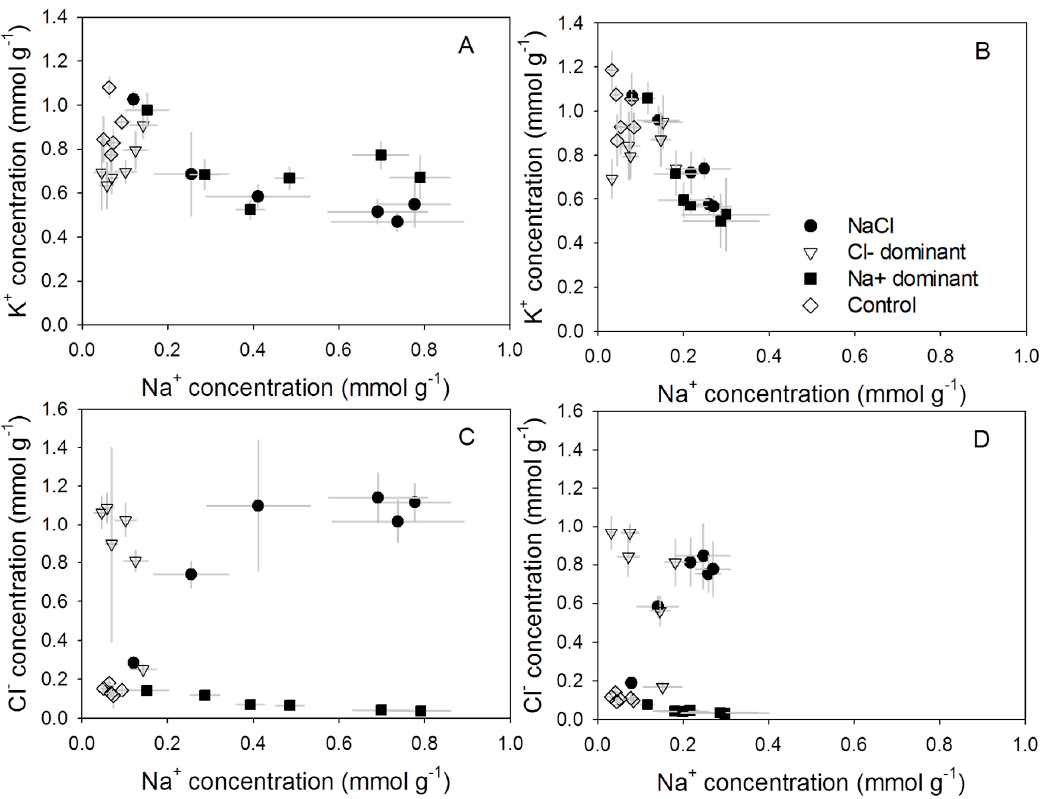
Figure 2. Relationships between ion concentrations in the leaves of cucumber genotypes Aramon ( A , C ) and Line-759 ( B , D ) in experiment 1. Values are means ± SD ( n = 5). Agronomy 2020 , 10 , x FOR PEER REVIEW